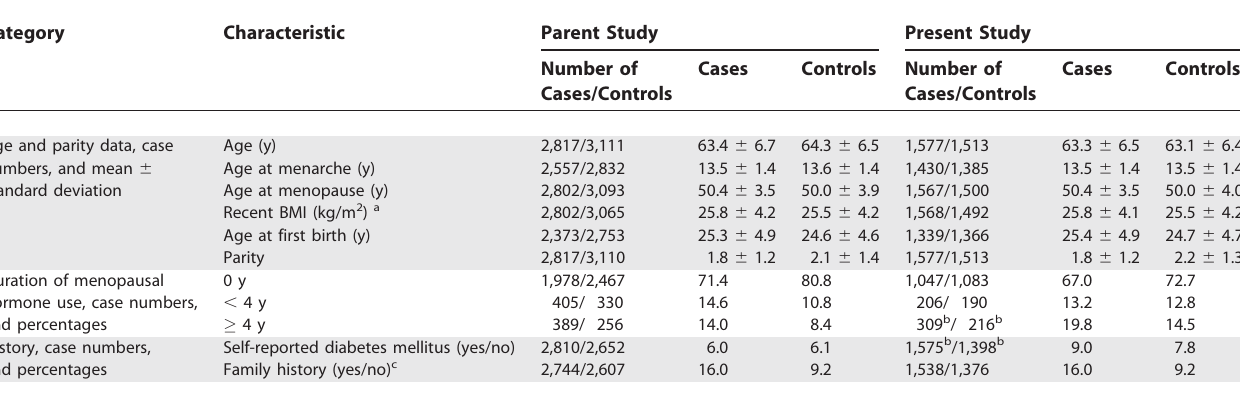
Table 1. Selected Characteristics of the Postmenopausal Sporadic Breast Cancer Cases and Controls Participating in the Present Study Compared to All Who Answered the Questionnaire in the Parent